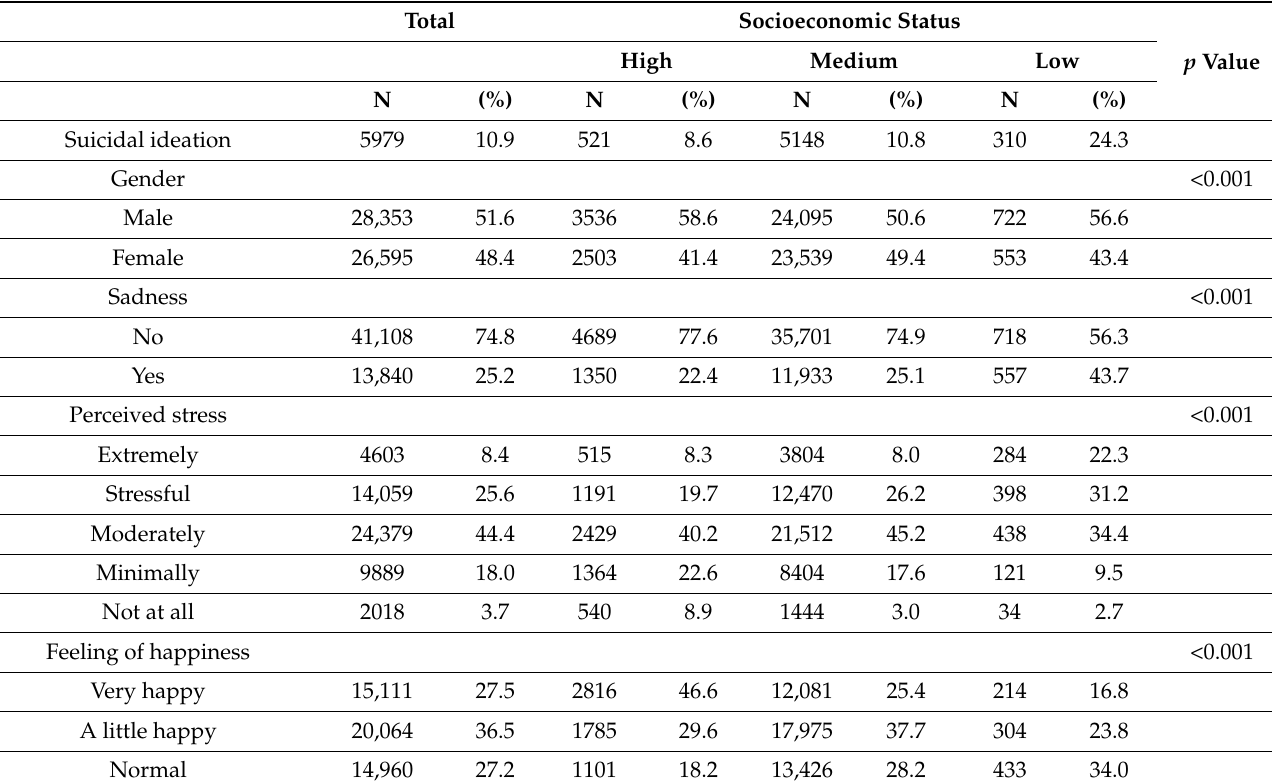
Table 3. General characteristics of the subject by socioeconomic